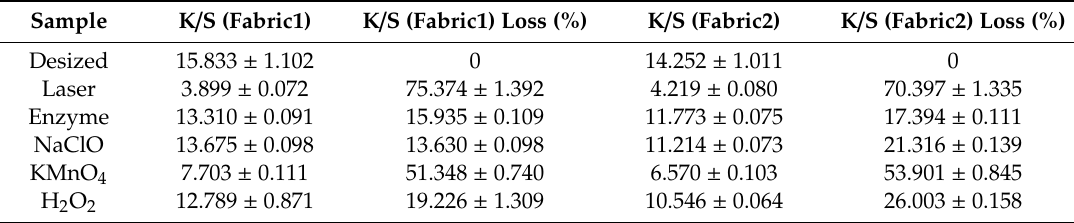
Table 4. K / S Values of samples with di ff erent bleaching